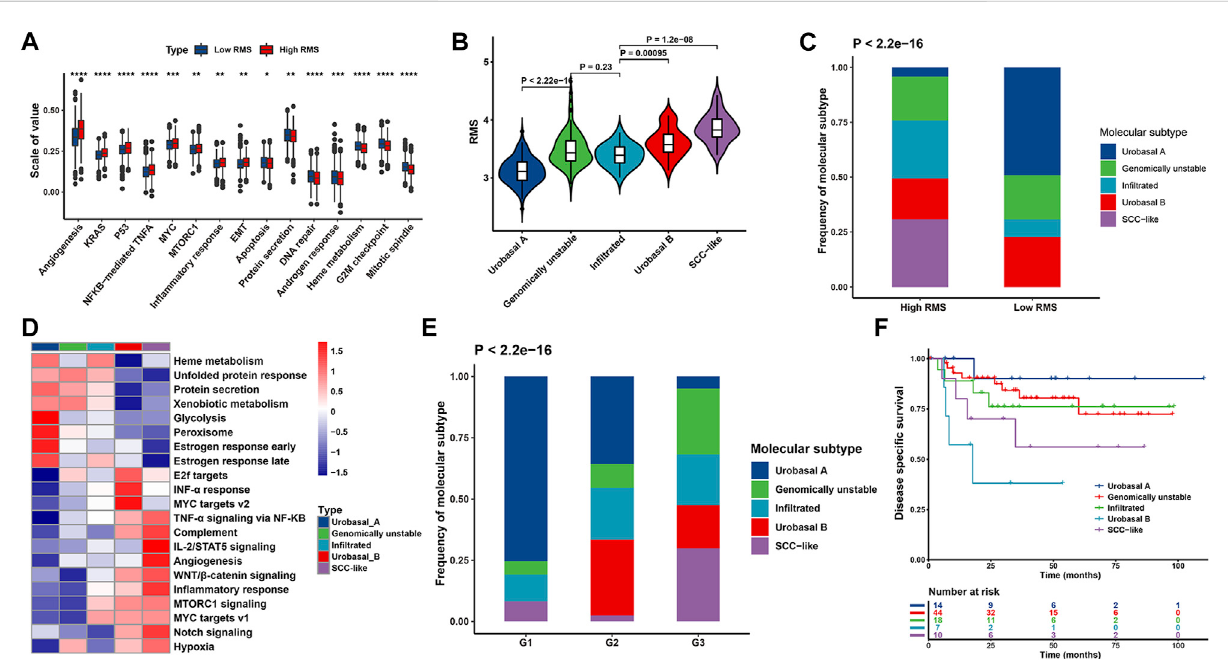
FIGURE 8 Biological function characteristics of the RMS model in BCa patients. (A) Boxplot representing the association between the RMS and known signatures based on the meta-GEO cohort. (B) Violin plot illustrating RMS distribution among fi ve molecular subtypes based on GSE32894 (C) Bar chart describing difference in the distribution of fi ve molecular subtypes between RMS-high and -low groups based on GSE32894 cohort. (D) Heatmap showing difference in the biological processes among fi ve molecular subtypes. (E) Bar chart exhibiting difference in the distribution of histological grade among fi ve molecular subtypes. (F) Kaplan-Meier curve revealing difference in OS among fi ve molecular subtypes for BCa cases at histological grade